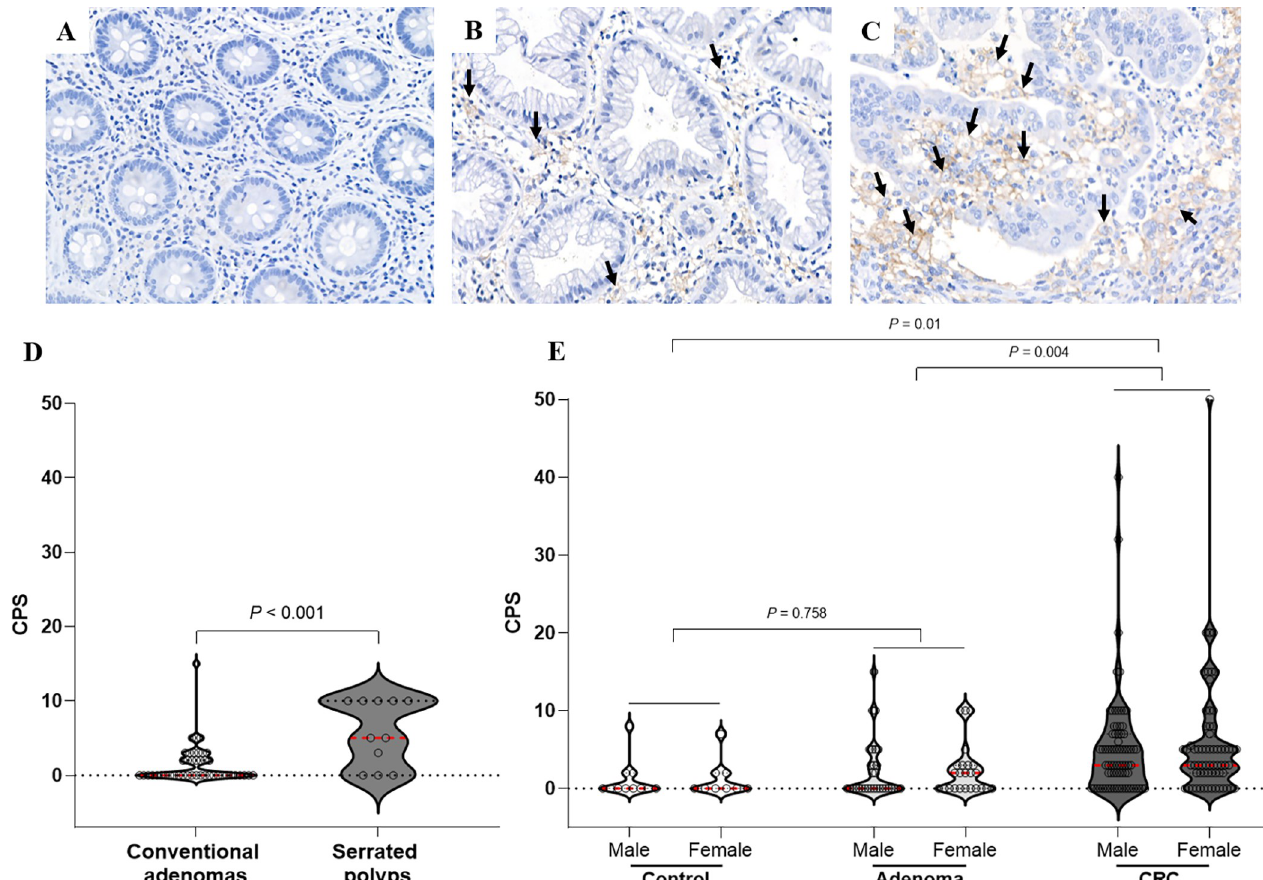
Fig 2. Expression of PD-L1 in colorectal tissues depending on histology. Representative immunohistochemical results of PD-L1 expression (arrows): (A) negative normal control, (B) sessile serrated lesion (adenoma), and (C) CRC (magnification, x20). (D) A statistically significant increase in PD-L1 combined positive score (CPS) was observed in serrated lesions/polyps within colorectal adenomas. (E) Colorectal cancer (CRC) showed a significantly higher PD-L1 CPS than control and colorectal adenomas.